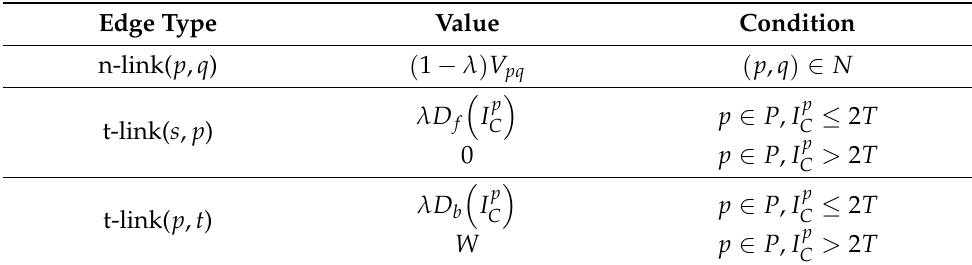
Table 1. Edge weight